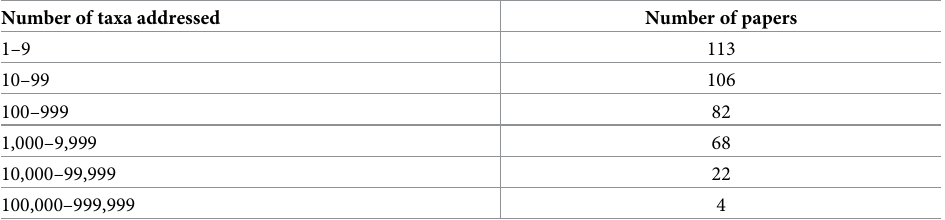
Table 4. Number of taxa addressed by papers using online species occurrence